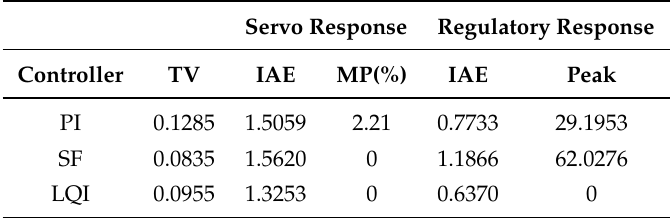
Table 3. Performance indices of the nominal closed-loop responses ( D = 0.4374 and R o =